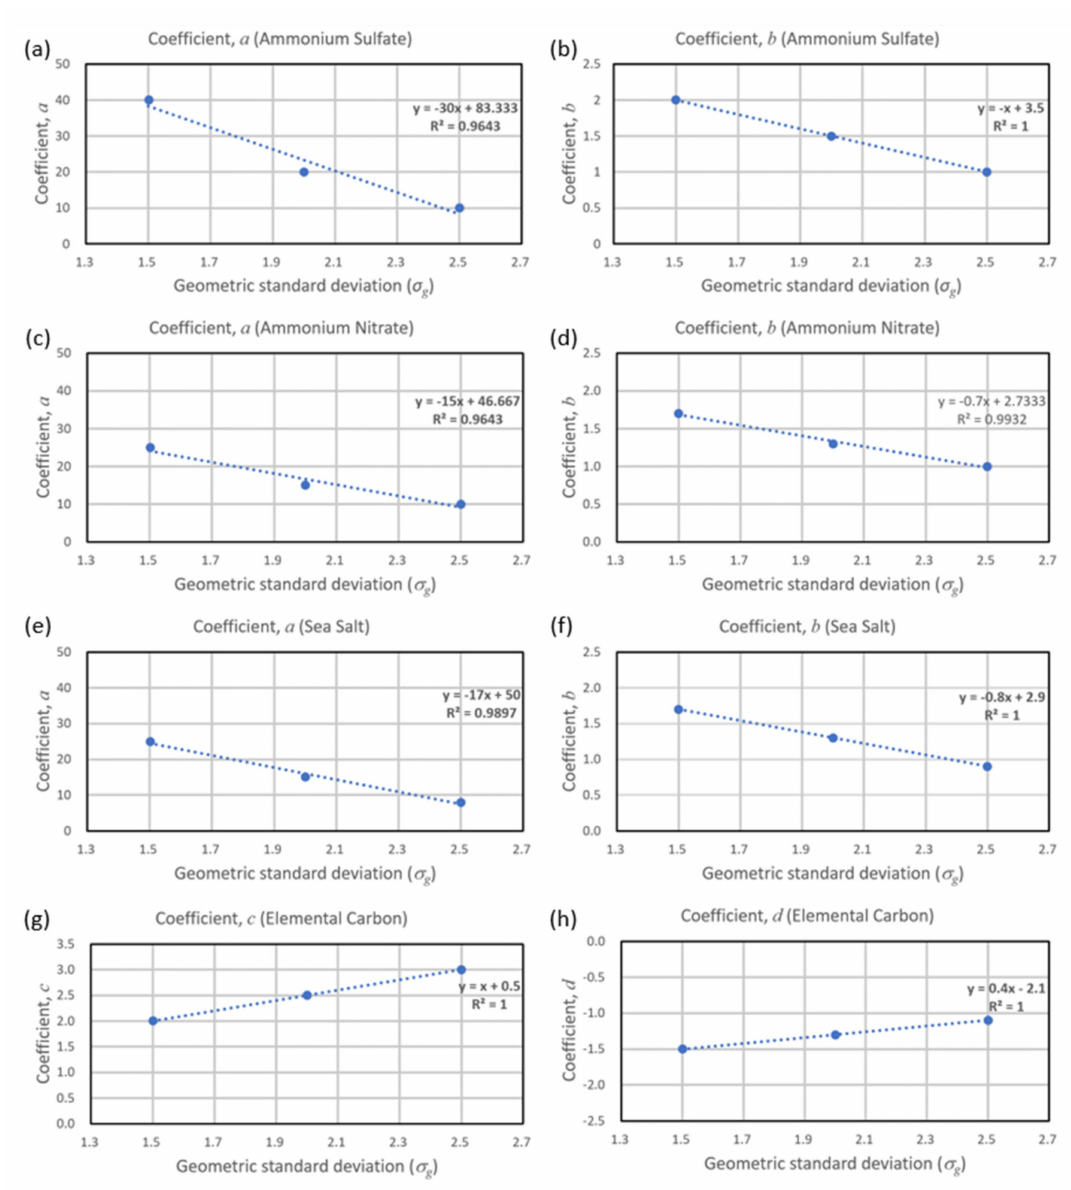
Figure 6. The determined mass extinction e ffi ciency coe ffi cients a and b as a function of geometric standard deviation in Equation (6) for ammonium sulfate ( a , b ), ammonium nitrate ( c , d ), and sea salt ( e , f ). For elemental carbon coe ffi cients, c ( g ) and d ( h ) are